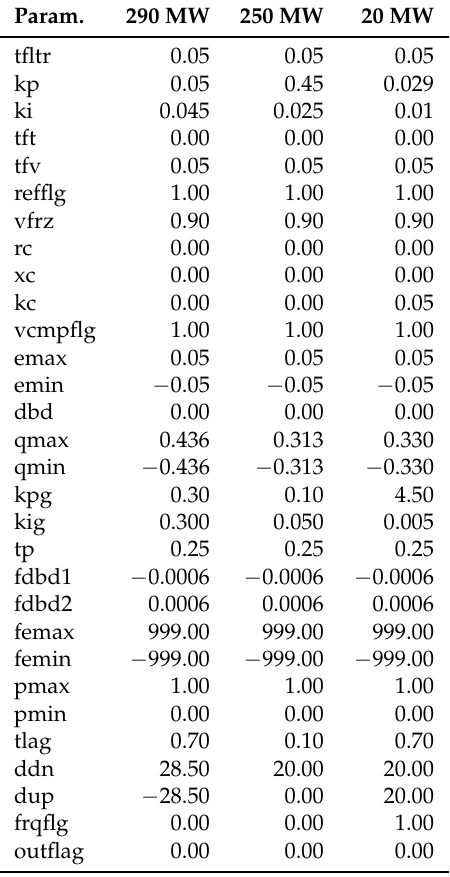
Table A3. REPC-A model: parameters of the solar PV plant.